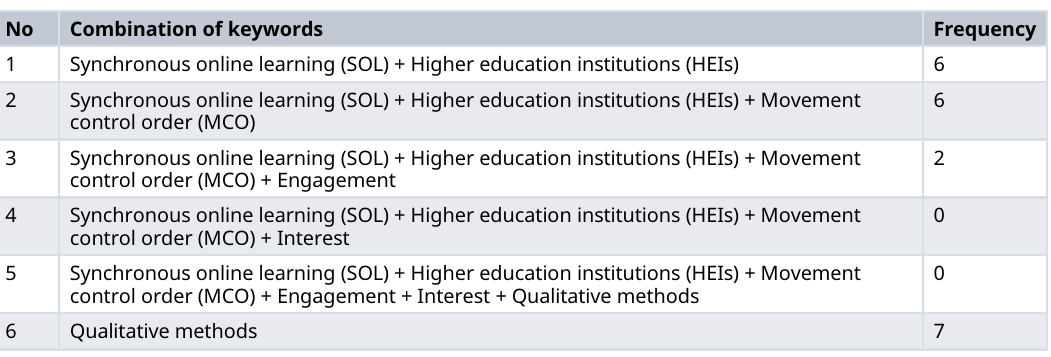
Table 4. Data extraction and synthesis